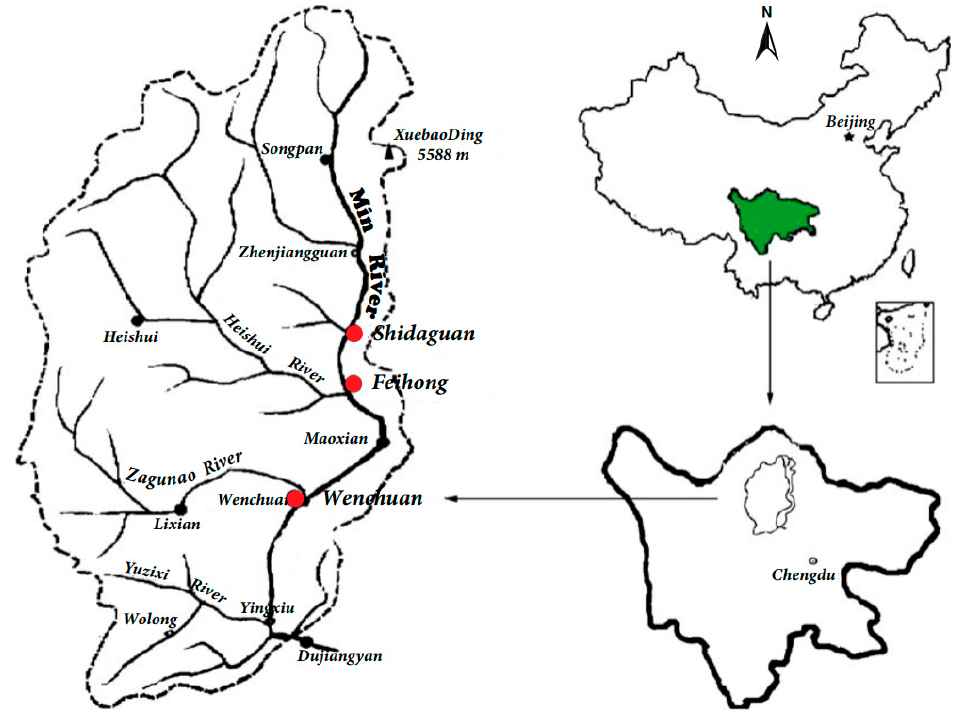
Figure 1. Location of sampling sites along the dry valley in the upper reaches of Min River (modified from Lu, et al. [47]). Table 1. Brief description of the study sites.